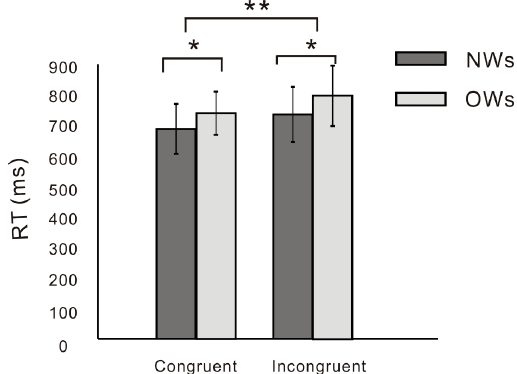
Figure 5. RT difference between OWs and NWs in food-related conflict task (* p < 0.05; ** p < 0.01).